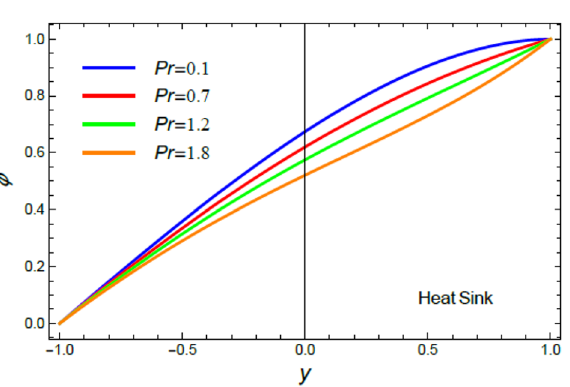
Figure 14. The nano-particles profile φ in the case of heat sink for different amounts of the Prandtl numeral Pr